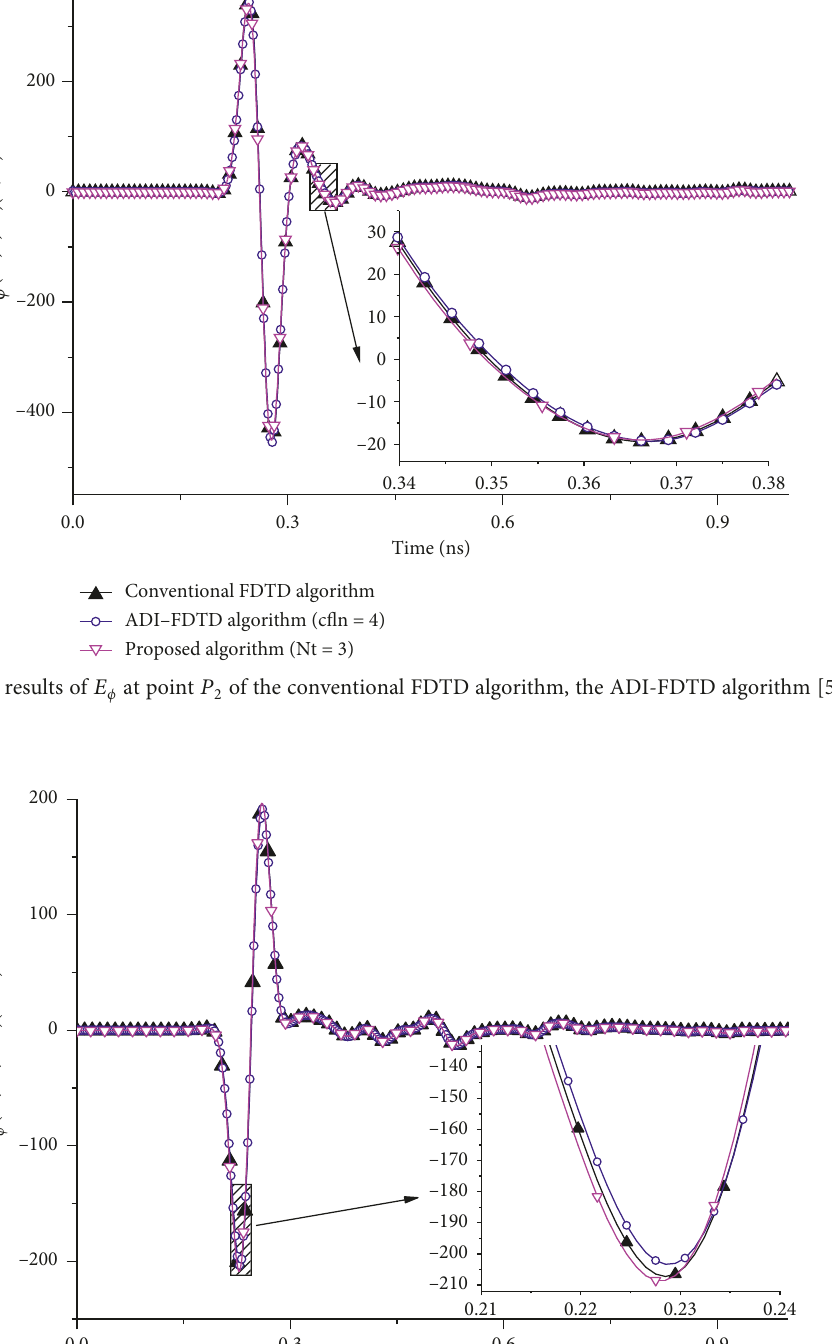
P 3 of the conventional FDTD algorithm, the ADI-FDTD algorithm [5], and the proposed